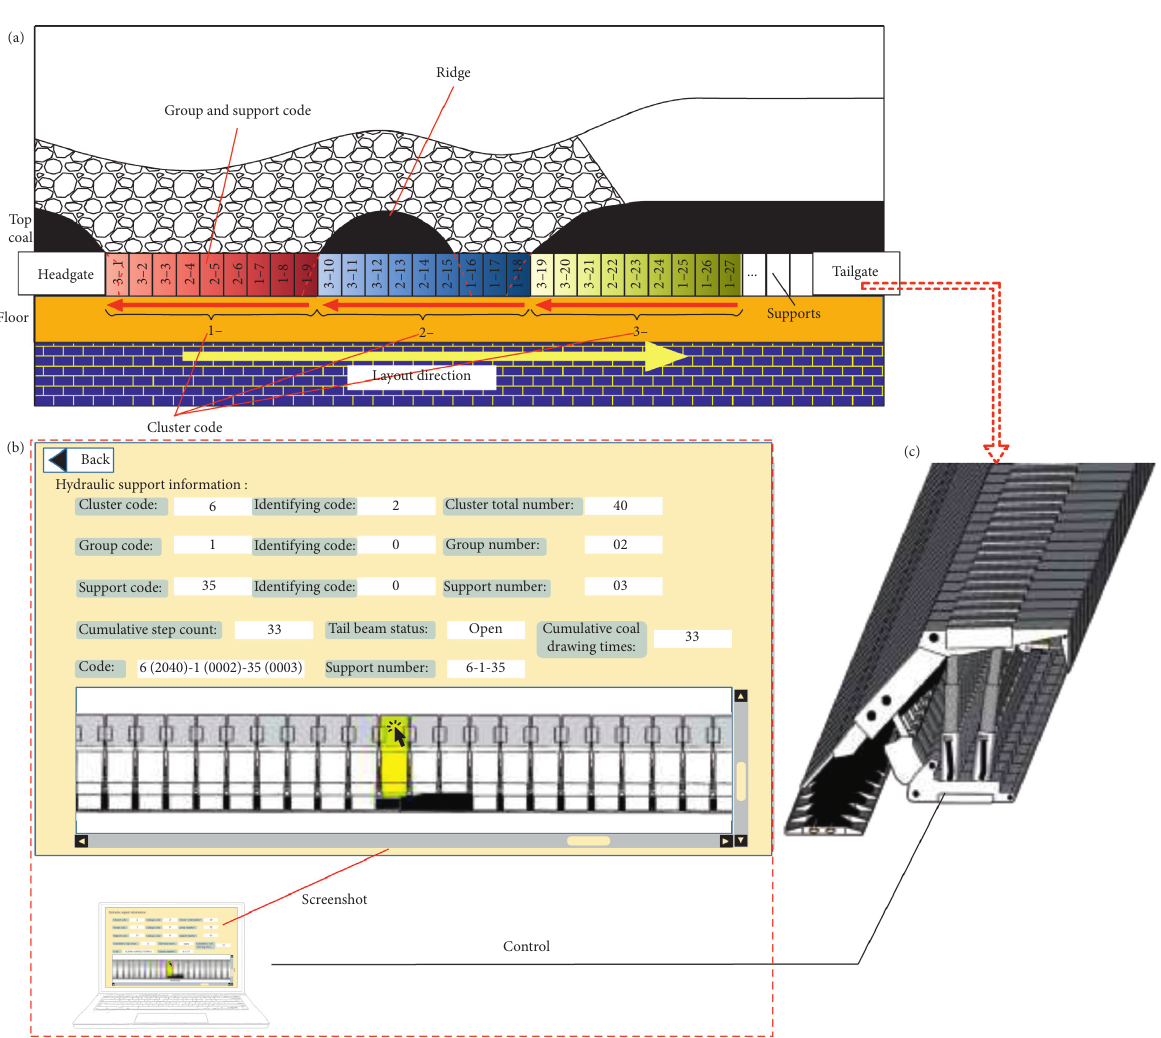
Figure 4: Cluster-group naming method: (a) support dividing into clusters and groups; (b) operation system; (c) controlled support.